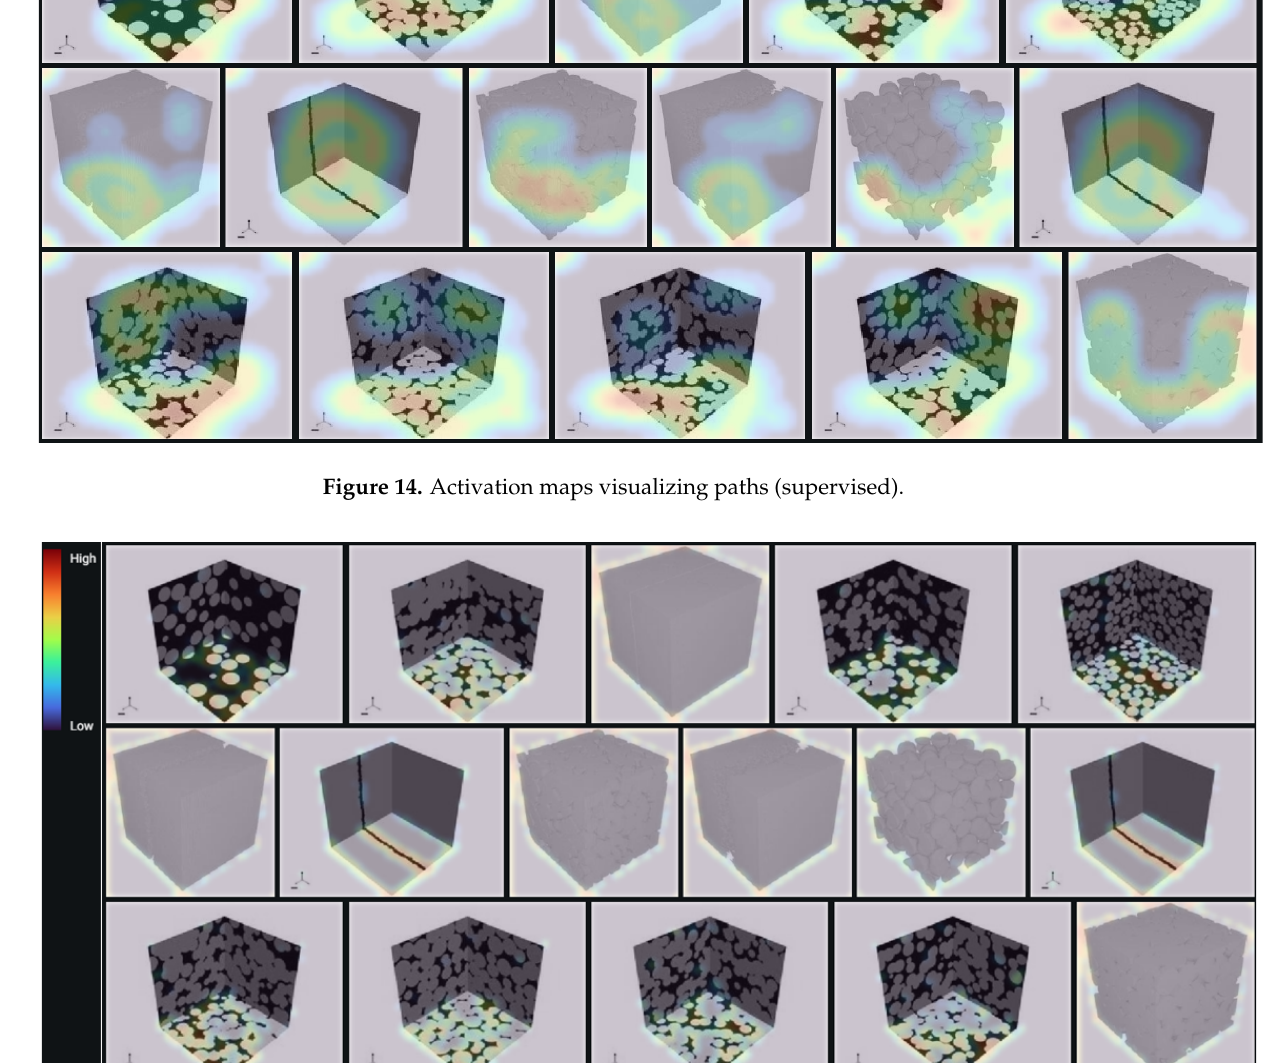
Figure 16. Anomaly score for some images. Figure 17. Image prediction and classification with supervised learning.